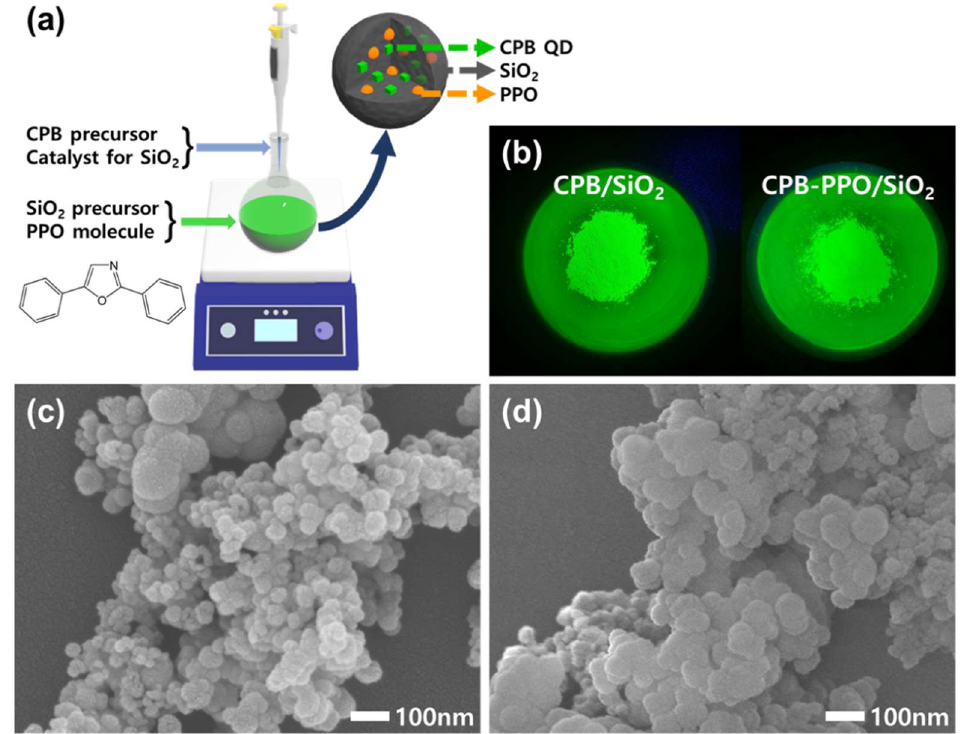
Figure 1. ( a ) A schematic illustration for the synthesis and structure of cesium lead bromide (CPB)– 2,5-diphenyloxazole (PPO)/SiO 2 nanoparticles (NPs). ( b ) Photographs of CPB/SiO 2 and CPB–PPO/SiO 2 NPs taken under UV irradiation. The characteristic green emission of the CPB QDs was observed. ( c , d ) Field-emission scanning electron microscopy (FE-SEM) images of CPB/SiO 2 NPs ( c ) and CPB-PPO/SiO 2 NPs ( d ).